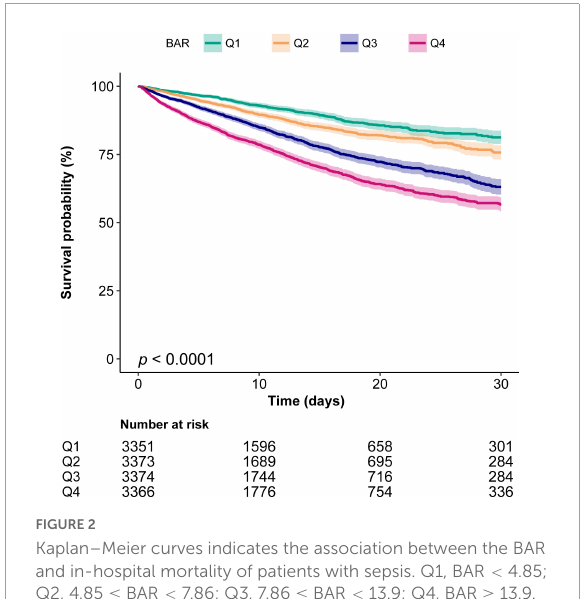
FIGURE2 Kaplan–Meier curves indicates the association between the BAR and in-hospital mortality of patients with sepsis. Q1, BAR < 4.85; Q2, 4.85 ≤ BAR < 7.86; Q3, 7.86 ≤ BAR < 13.9; Q4, BAR ≥ 13.9. The curved line and shaded areas depict the estimated values and their corresponding 95% confidence intervals. Only patients with a hospital length of stay ≤ 30 days are